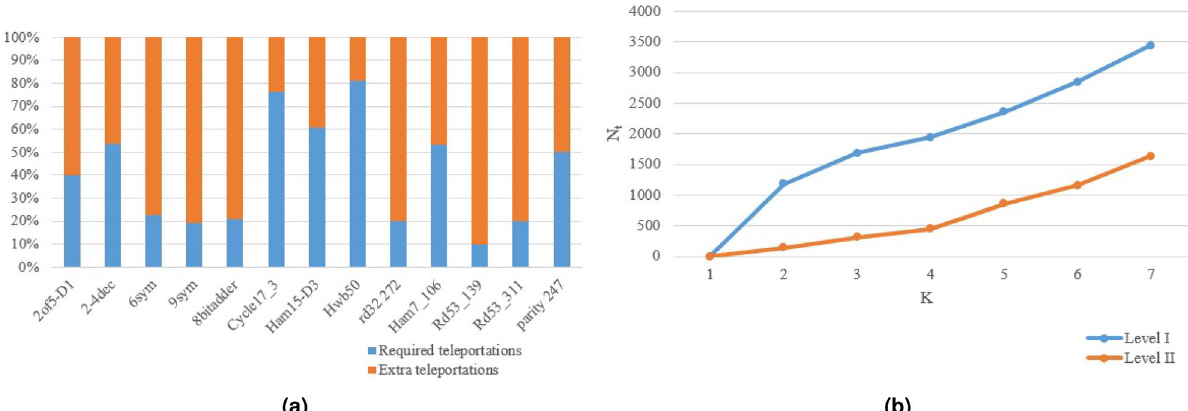
Figure 5. ( a ) Percentage of required number of teleportations to extra teleportations on Circuits 1 to 15. ( b ) The effect of the number of units on number of communications of Level I and II on Circuit